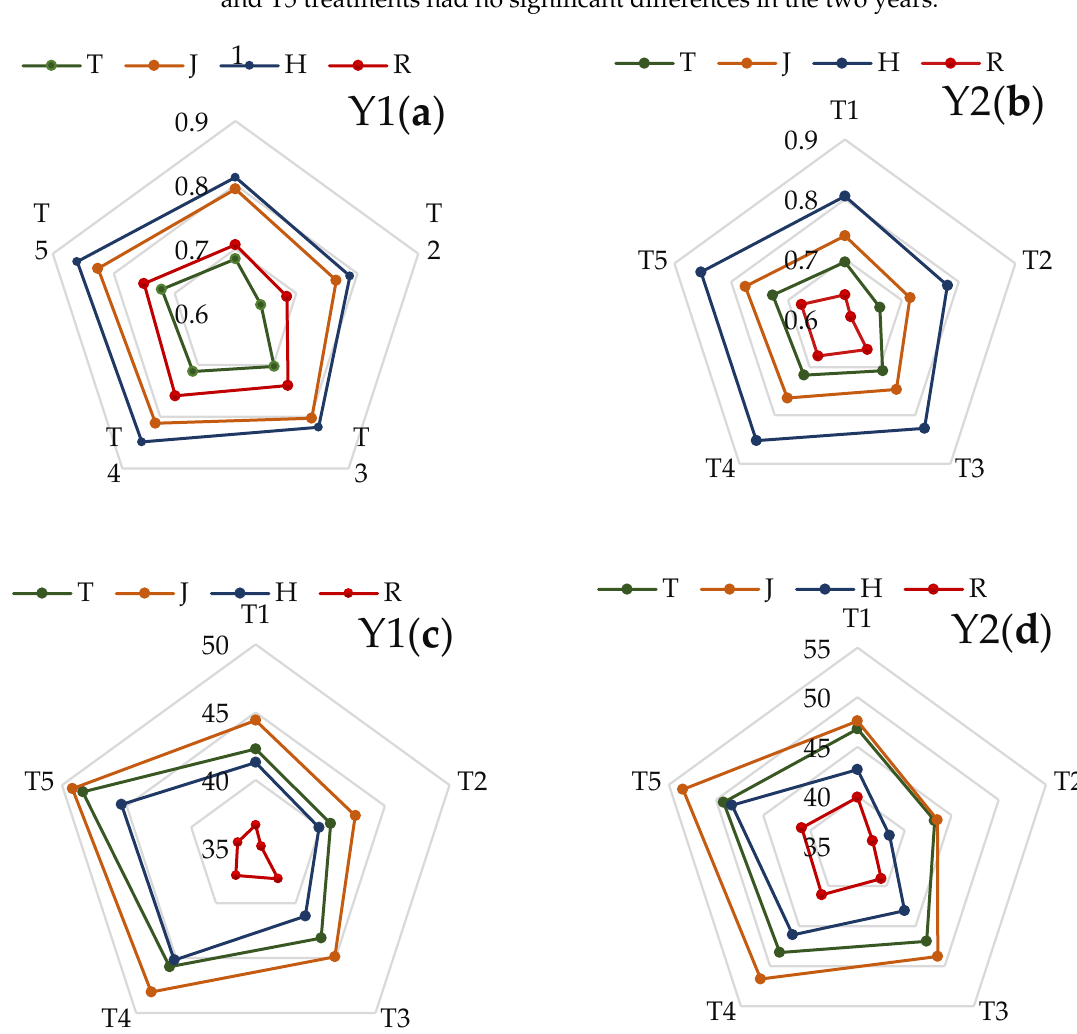
Figure 2. F v /F m ( a , b ) and SPAD ( c , d ) under the different HA treatments. Note: T1 represents 100% N (110 kg · ha − 1 ), T2 represents 70% N and 30% HA, T3 represents 50% N and 50% HA, T4 represents 30% N and 70% HA, T5 represents 0% N and 100% HA (1500 kg · ha − 1 ), and T, J, H and R represent the tillering, jointing, heading, and ripening stages, respectively.